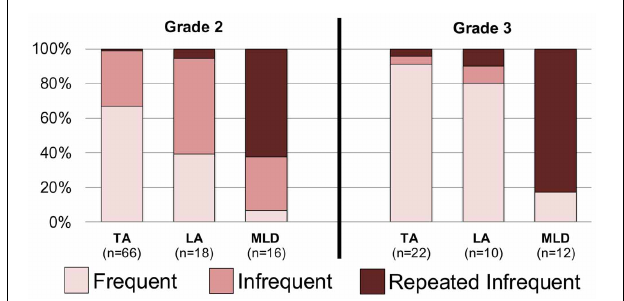
FIGURE 2 | The percentage of error types made by children who made errors on the Written Number Task at Grades 2 and/or 3, reported separately for children with typical achievement (TA) or low achievement (LA) in mathematics or mathematical learning disability (MLD). Repeated infrequent errors indicate making an infrequent error during both years of the study, although not necessarily the same infrequent